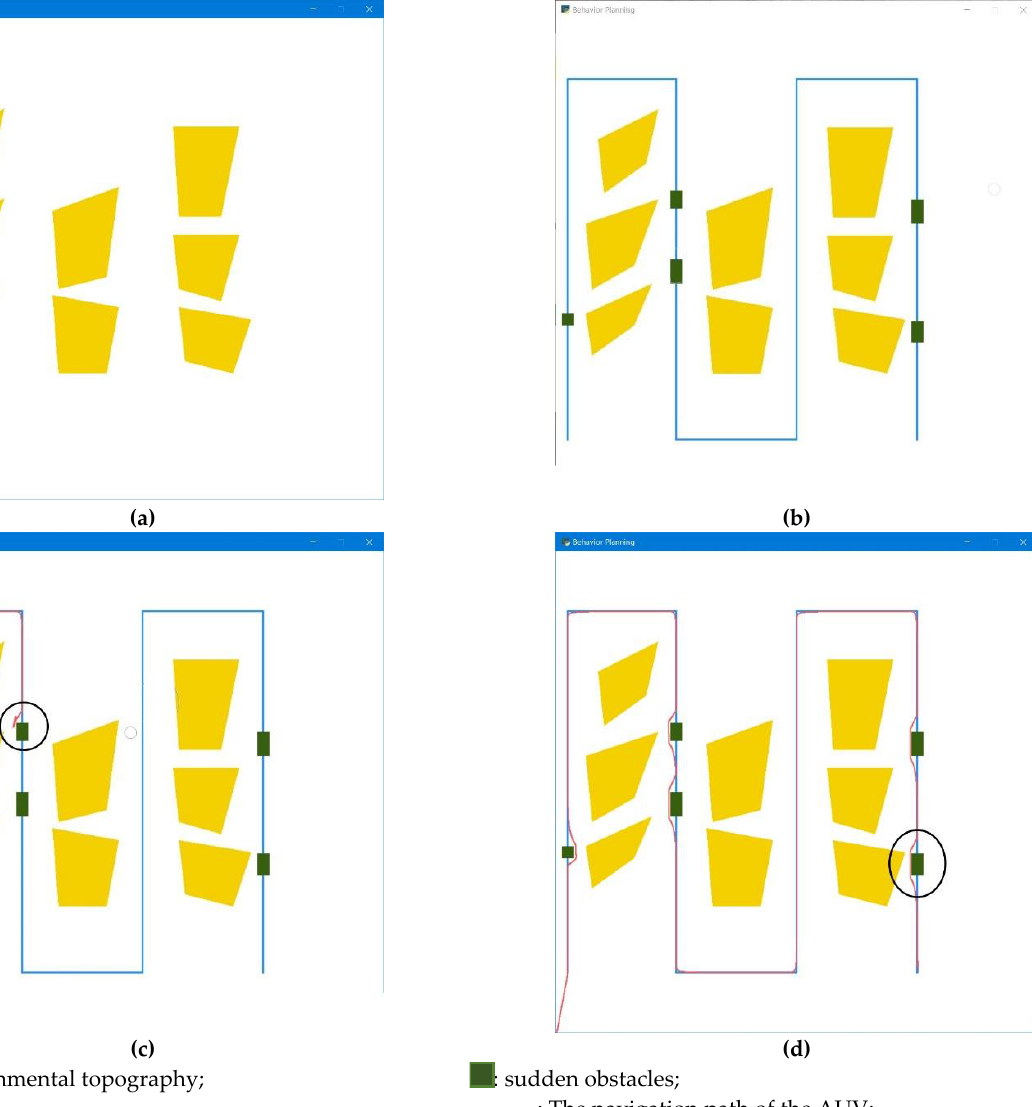
Figure 7. Motion planning of patrol inspection in broad waters. ( a ) marine environment, ( b ) global planning, ( c ) path following and obstacle avoidance, ( d ) end of the test.